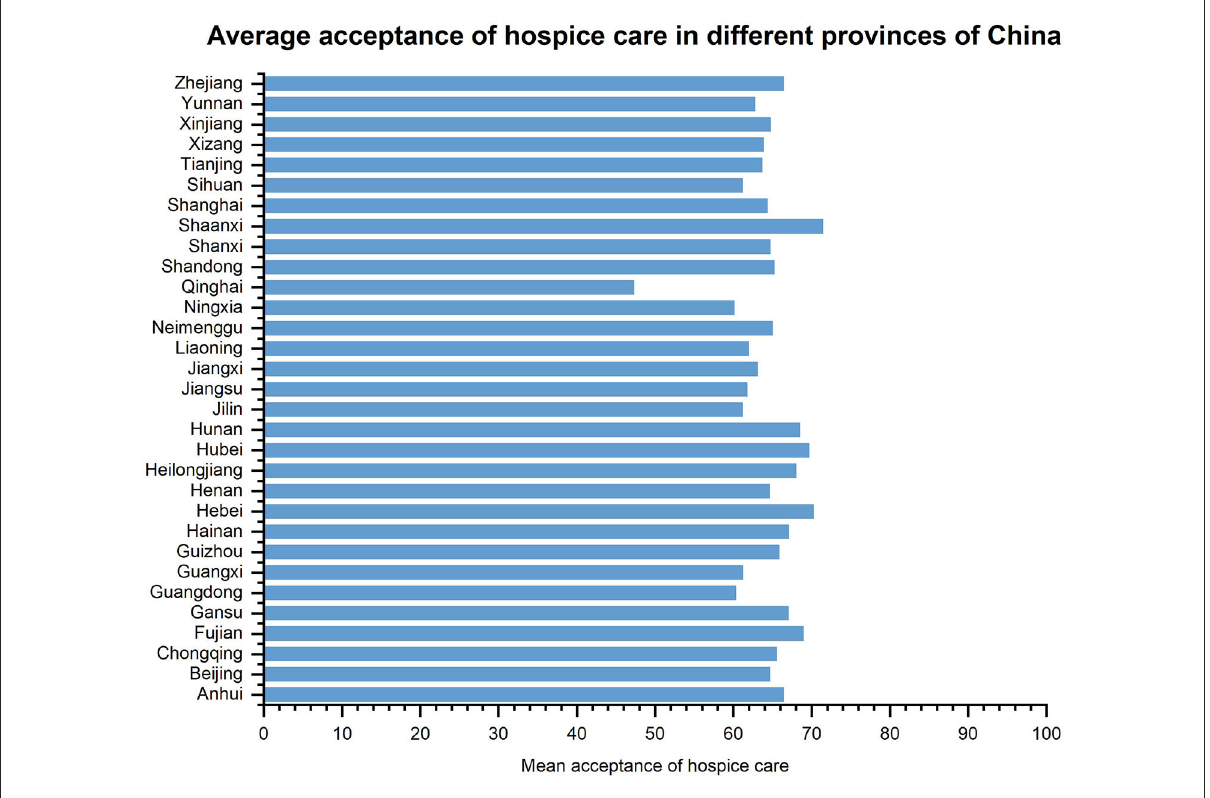
FIGURE2 Average acceptance of hospice care in different provinces of